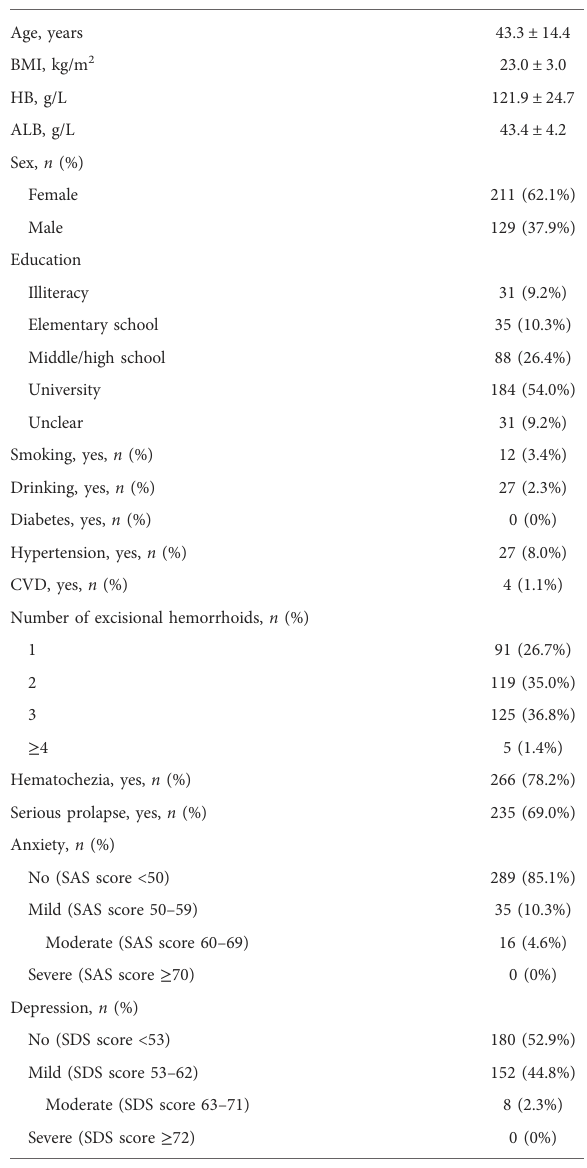
TABLE 1 Demographics and clinical data at